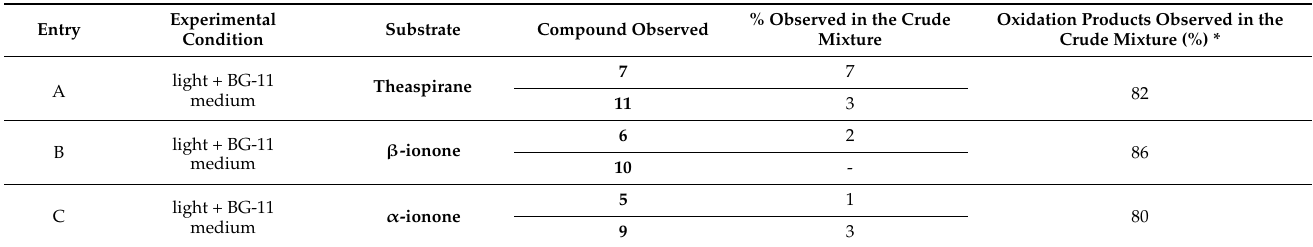
Table 3. Oxidation of substrates 2 – 4 (3 g/L) in BG-11 medium with a continuous illumination of 78 µ mol/m2/s. * All the value reported in the table are derived from the mathematical average of three different samples integrating the peaks of the chromatogram of the crude